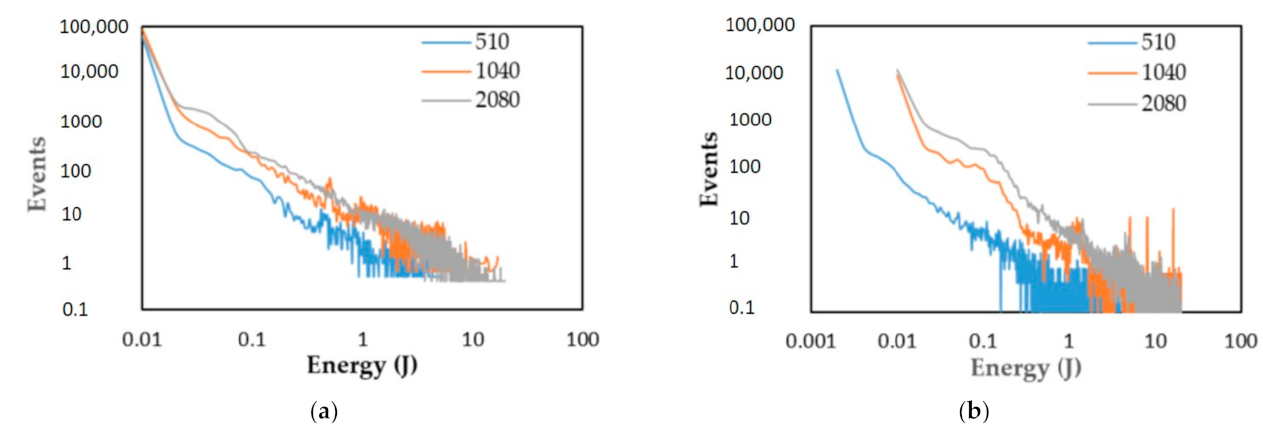
Figure 3. Energy spectra for the effect of rotor speed on double rotor design, for particle size ( a ) − 19.0 + 16.7 and ( b ) − 13.2 +